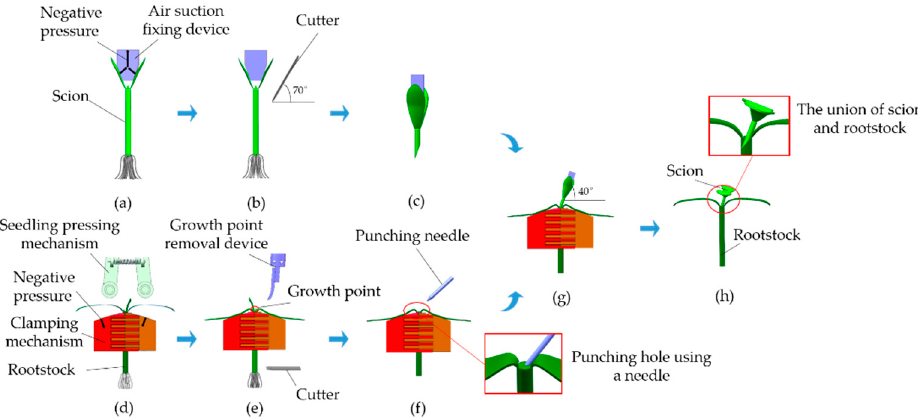
Figure 2. Grafting process of inclined inserted grafting method: ( a ) holding the scion; ( b ) cutting the stem of scion; ( c ) the scion after cutting; ( d ) holding the rootstock; ( e ) cutting the root and removing the growth point of rootstock; ( f ) punching a hole in the rootstock; ( g ) inserting the scion into the rootstock; ( h ) seedling after grafting.